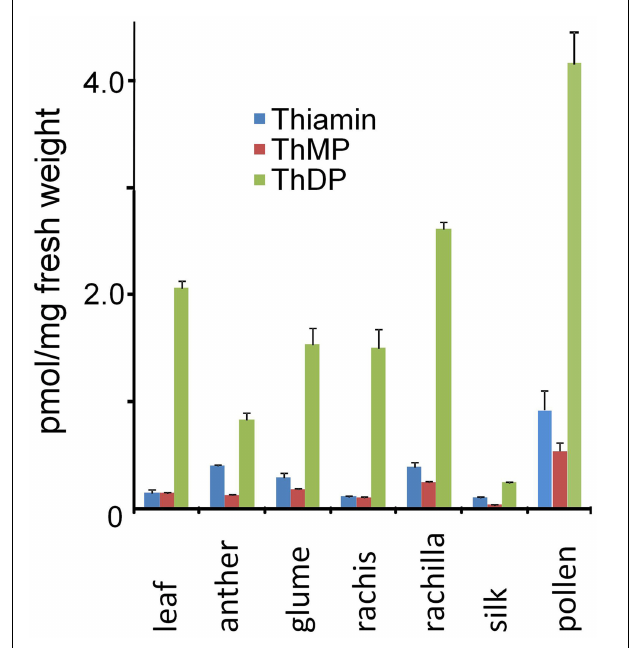
FIGURE 6 | Thiamin and thiamin phosphate ester contents of maize leaves, pollen, inflorescence and floral organs. Thiamin content (pmol/mg of FW tissue) was determined as described in Methods. Pre-anthesis anthers were sampled 1–2 days prior to expected anthesis. Bars: Standard error of the mean, n =